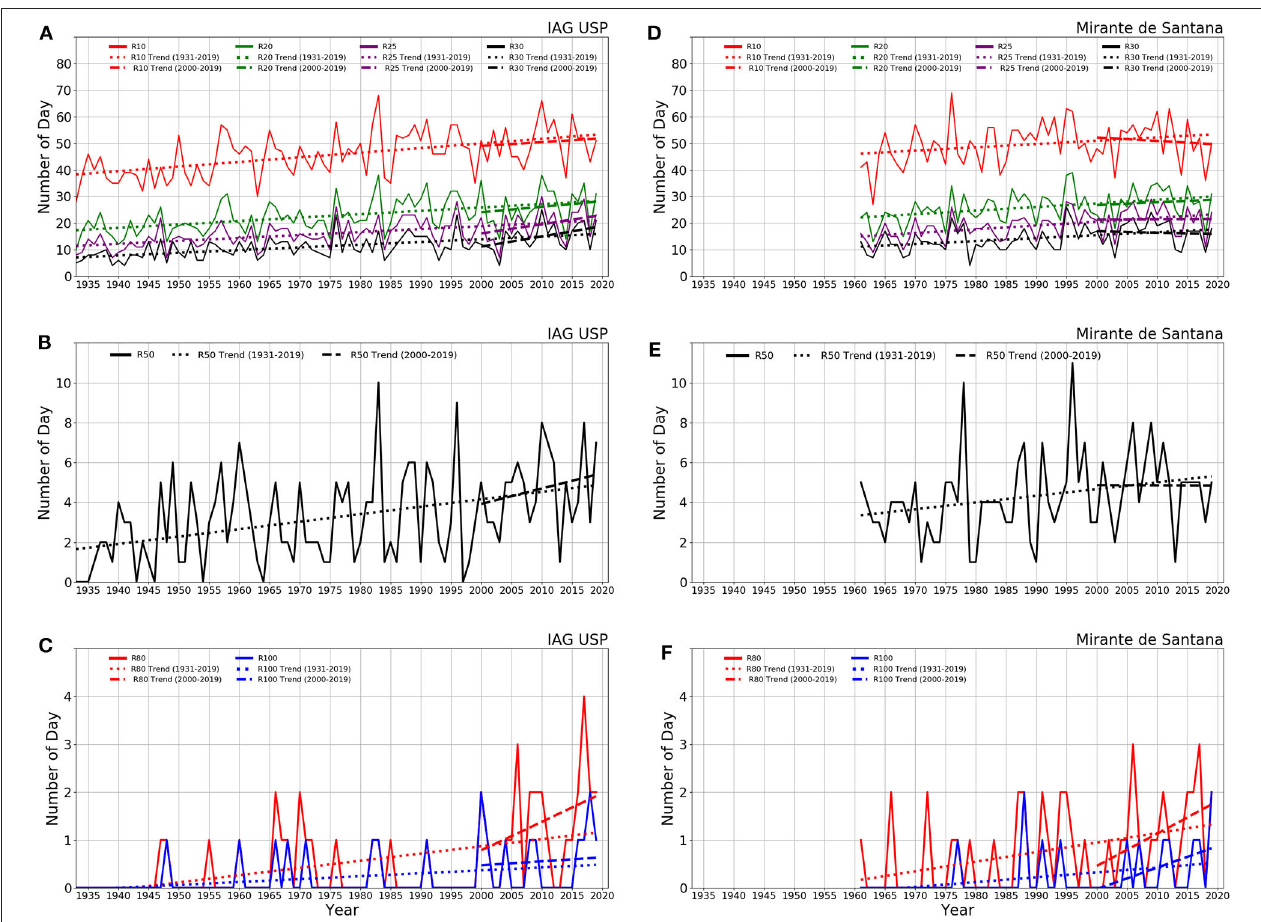
FIGURE 3 | Time series of numbers of days with precipitation above 10mm (R10), 20mm (R20), 25mm (R25), 30mm (R30), 50mm (R50), 80mm (R80), and 100mm (R100) for IAG-USP during 1931–2019 (A–C) and Mirante de Santana during 1961–2018 (D–F) . Linear trends are shown with full (since 1961) and broken (2000–2019) lines. Linear trends are shown with full (since 1961) and broken (2000–2019)